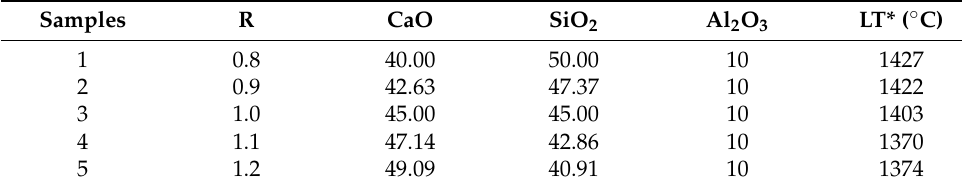
Figure 1. Phase diagram of the CaO-SiO 2 -Al 2 O 3 system. Table 1. Composition ratios of the CaO-SiO 2 -Al 2 O 3 system with different R (mass %). Samples